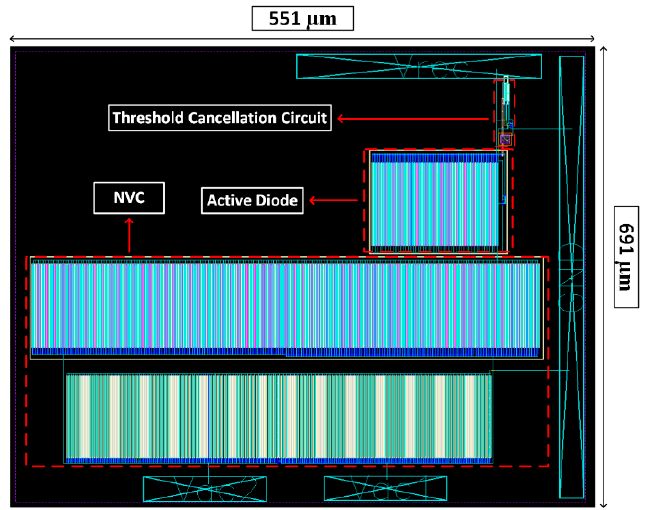
Figure 3. Physical layout of the proposed CMOS rectifier.